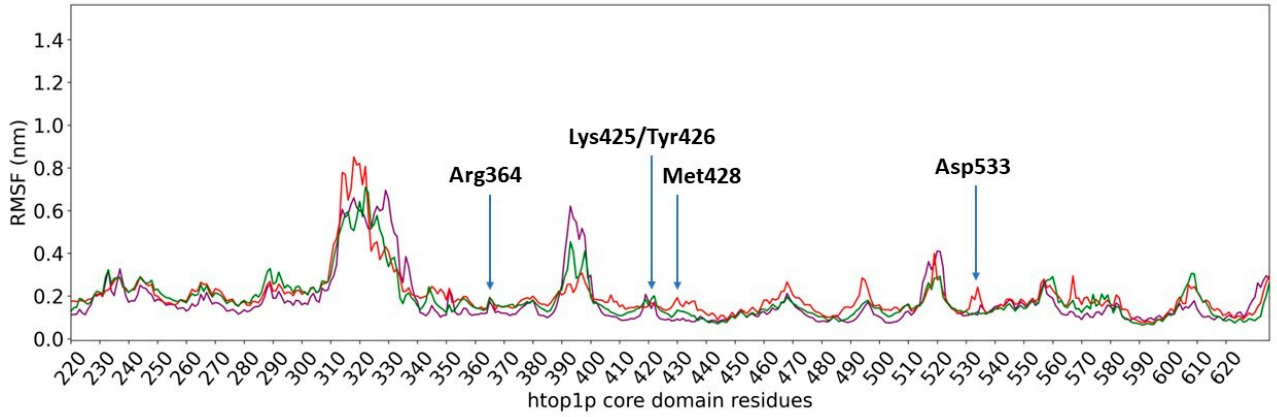
Figure 7. RMSF (root mean square fluctuation) of the core domain of hTop1p. In purple: RMSF Htop1p core domain in complex with compound 6 . In red: RMSF Htop1p core domain in complex with compound 7 . In green: RMSF Htop1p core domain. In evidence the root mean square fluctuation of the C α of the amino acids Arg364, Lys425, Tyr426, Met428 and Asp533, important in constituting the binding site of compounds c6 and c7